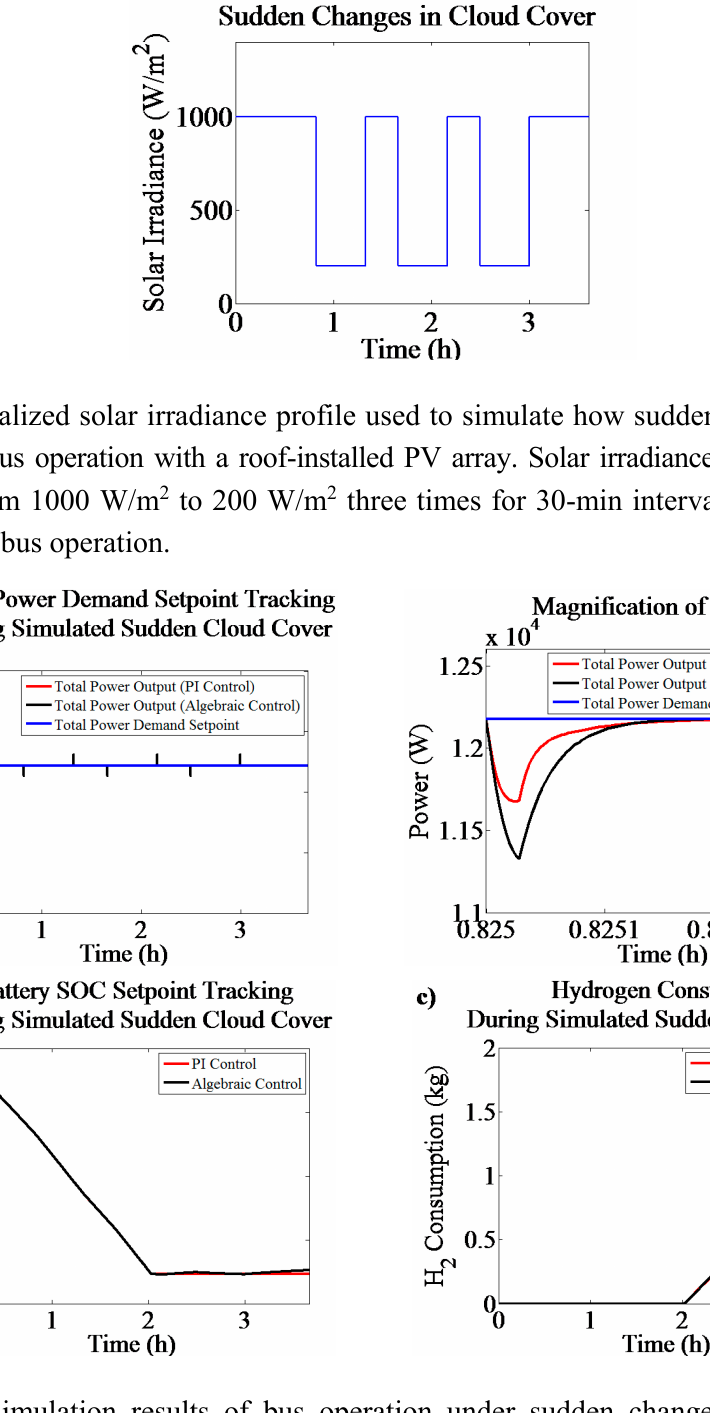
Figure 10. Simulation results of bus operation under sudden changes in cloud cover: ( a ) Total power demand set point tracking, along with a magnified plot illustrating details; ( b ) battery SOC set-point tracking; and ( c ) hydrogen consumption profile. The bus is able to meet its power demands under algebraic and PI control reasonably well despite abrupt, large changes in solar irradiance. Performance in meeting power demands is slightly better under PI control than under algebraic control. The bus is able to maintain battery SOC at 65% while consuming approximately the same amount of hydrogen under both control